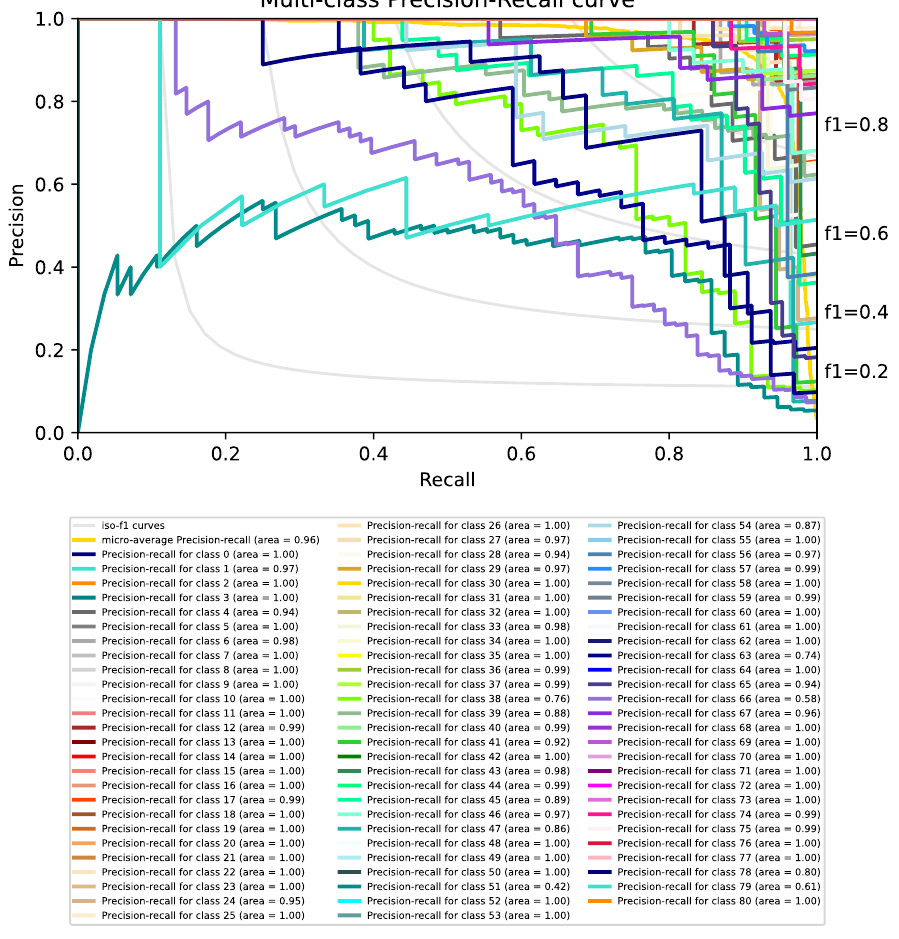
Figure 9. Multi-Class Precision-Recall